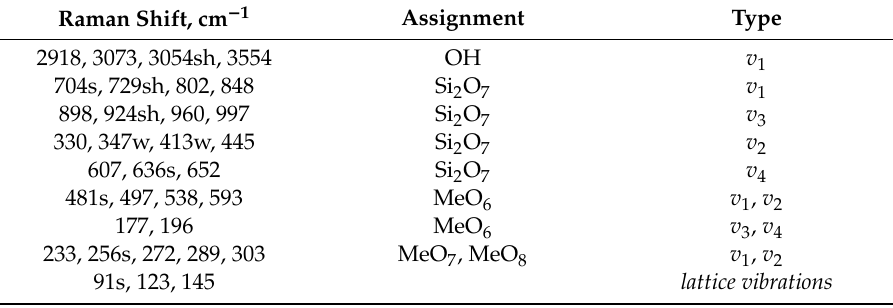
sh = shoulder. s = strong intensity. w = weak.